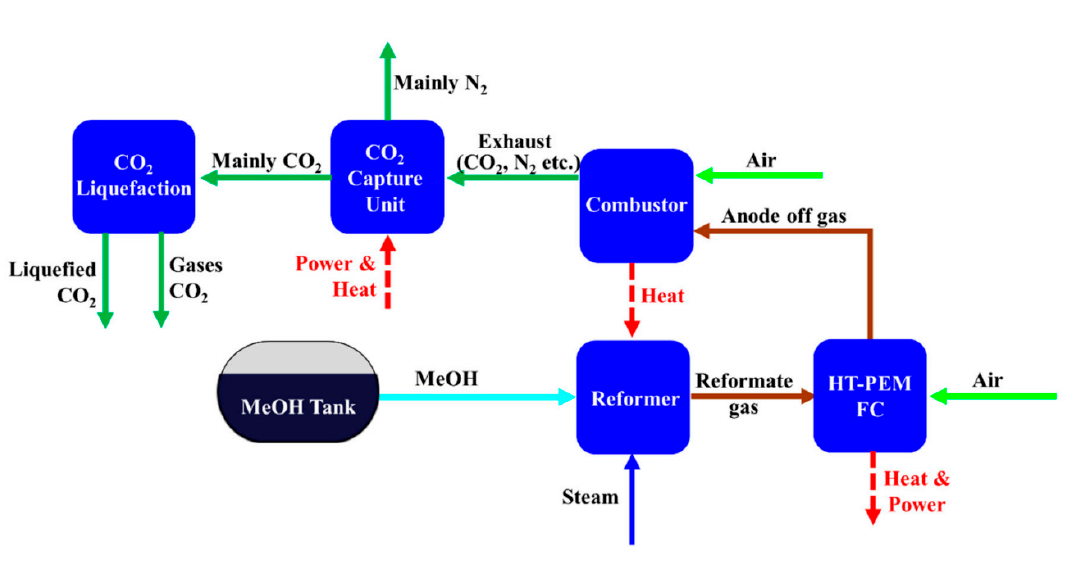
Figure 8. Block diagram of MSR-based system [150].